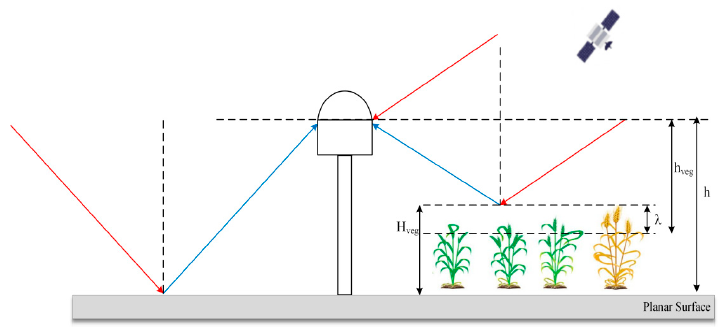
Figure 3. Schematic diagram of wheat height retrieval.